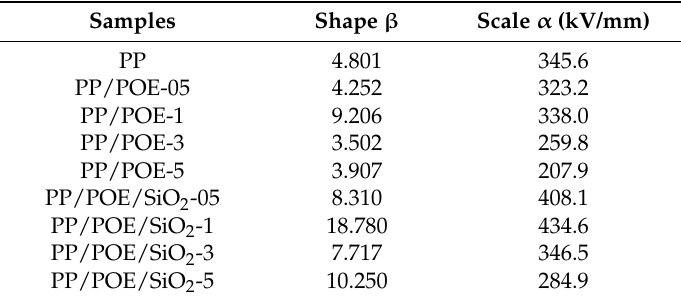
Table 2. Weibull statistic data of breakdown